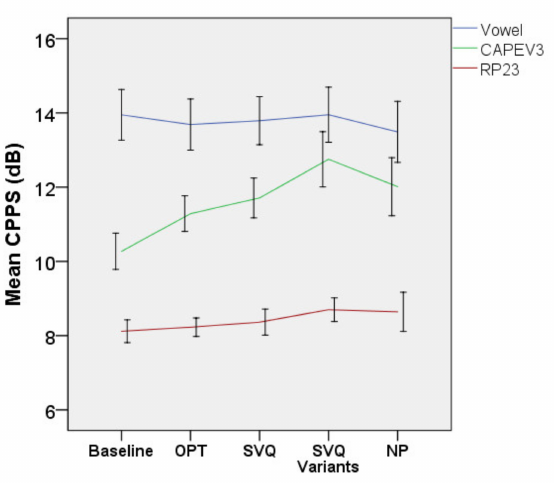
Figure 8. Smoothed cepstral peak prominence of all vocal tasks. Error bars indicate 95% CI for the mean. Abbreviations: CAPEV3, third CAPEV phrase and RP, Rainbow